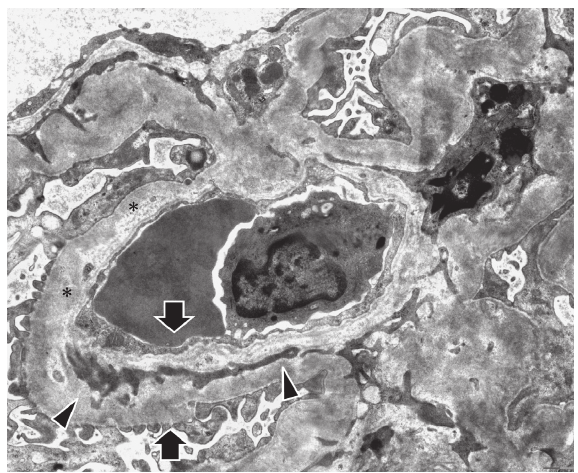
Figure 3: Electron microscopy revealed wrinkling of the glo- merular basement membrane, expansion of the subendothelial space (asterisks), mesangial interposition (arrowhead), and redu- plication of the glomerular basement membrane (arrow) (electron microscopy, original magnification ×